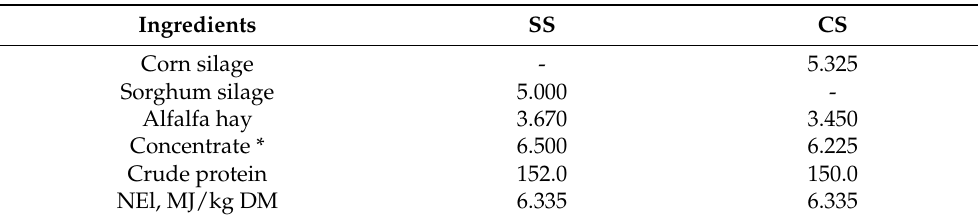
Table 1. Diets ingredients (kg of dry matter (DM)), crude protein (g/kg DM) and energy (NEl, MJ/kg